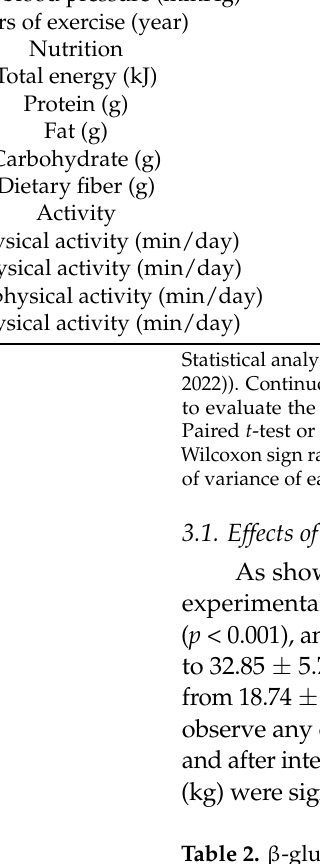
Table 2. β -glucan supplementation improves muscle strength in